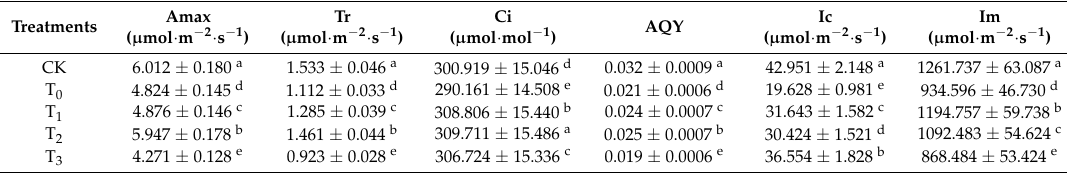
Table 4. Effect of the NO donor on the photosynthetic parameters of Larix gmelinii seedlings under enhanced UV-B